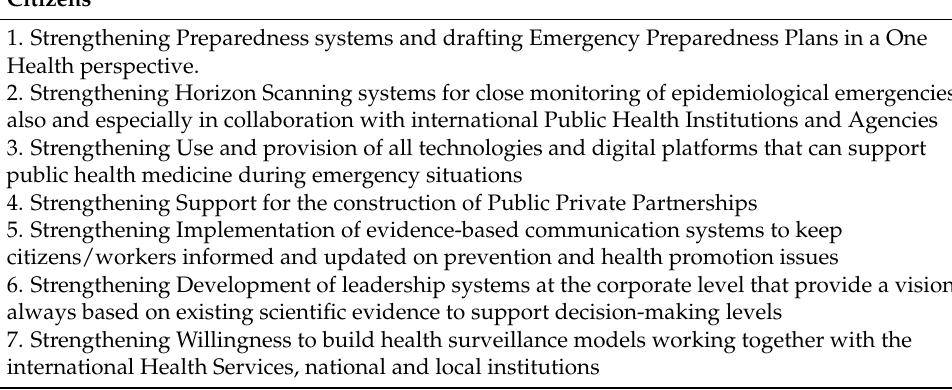
Table 4. The seven actions to strength the collaboration between companies, governments, workers and citizens to manage health